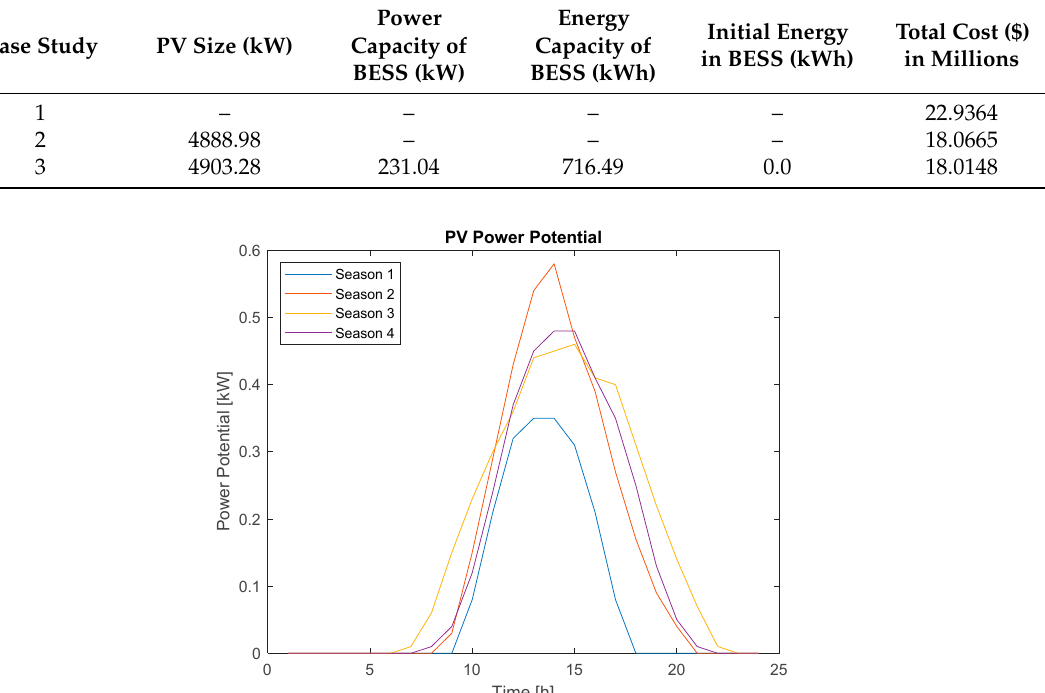
Table 6. Summary of optimal energy storage and PV sizes for case studies, the deterministic approach.